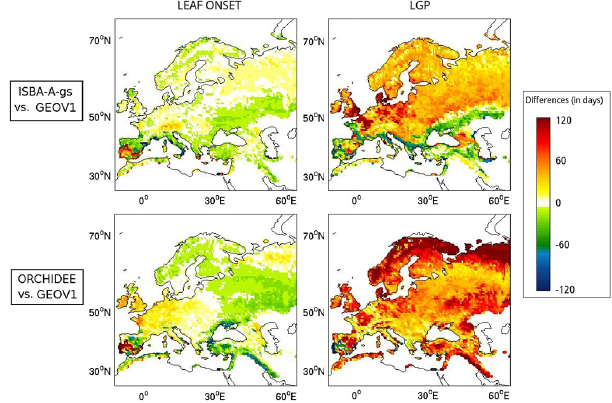
Figure 8. Mean differences in simulated (left) leaf onset values and (right) LGP of (top) ISBA-A-gs and (bottom) ORCHIDEE, over the 1991–2008 period.